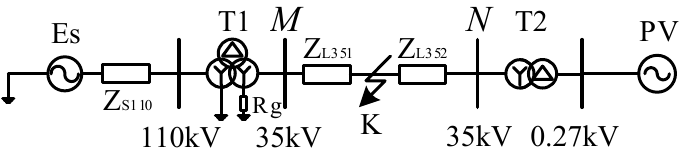
Figure 2. The equivalent circuit diagram with the fault on the tie-line.